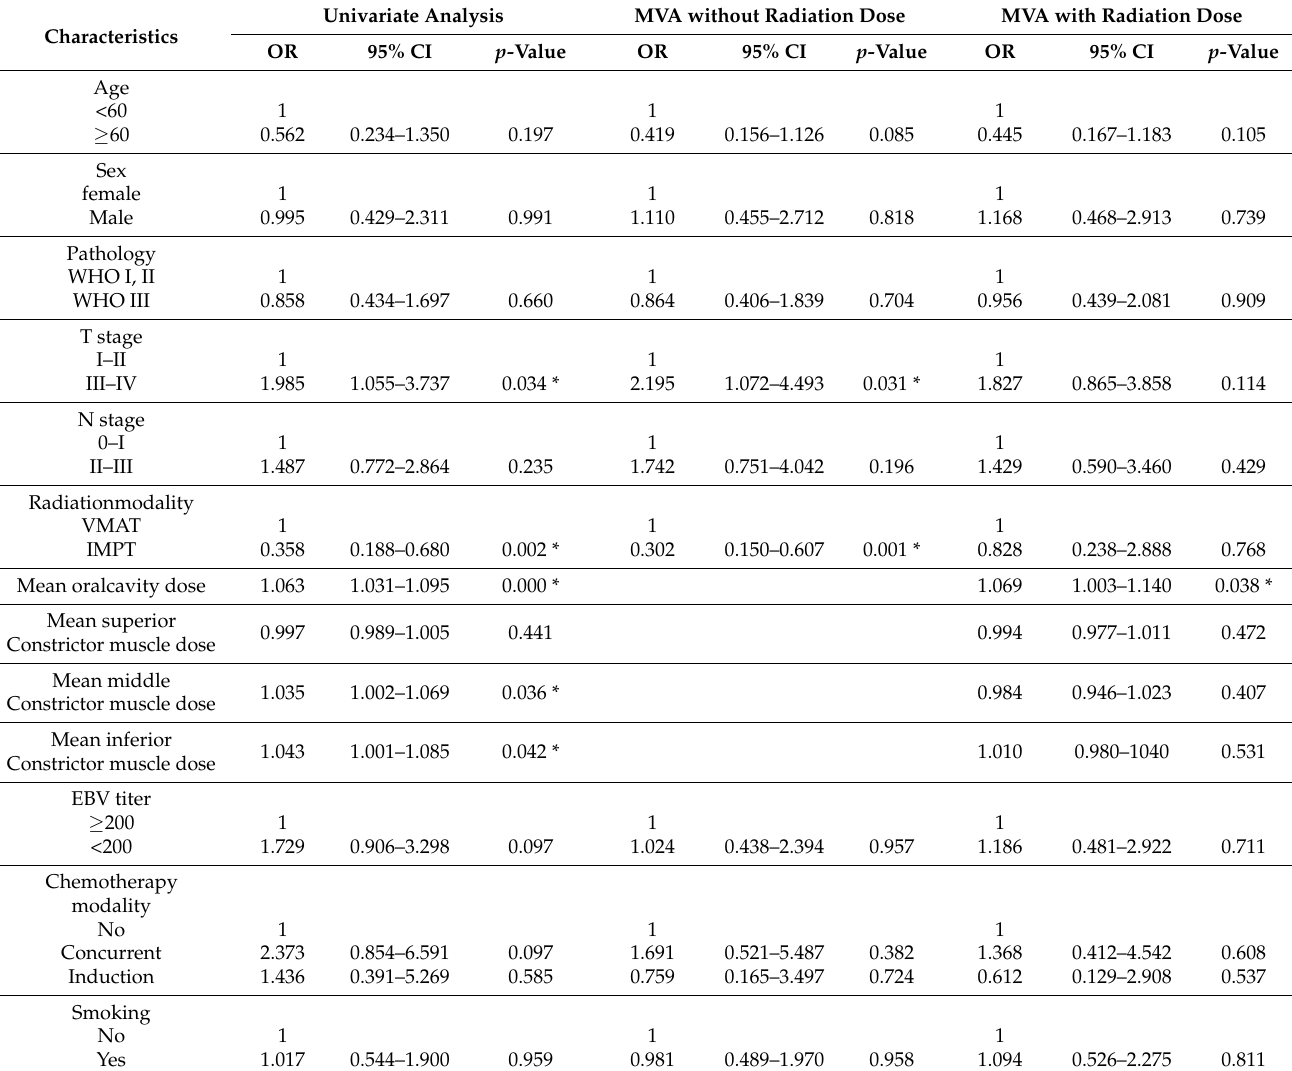
Table 4. Univariate and multivariate analysis of the association with weight loss ( ≥ 7%) or nasogastric tube insertion.